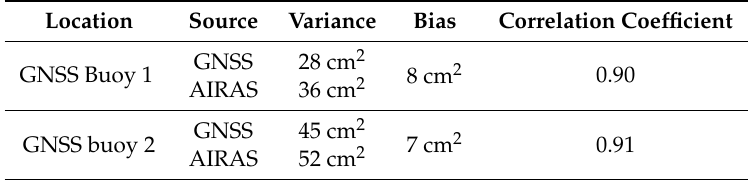
Figure 12. Unified VPS in frequency domain of WSSE measured by AIRAS and GNSS buoys. Red (blue) line represents the GNSS buoy (AIRAS) data. Table 3. The Cal/Val result of the AIRAS measured WSSE. Variance was estimated from the VPSs of the GNSS buoys and the AIRAS